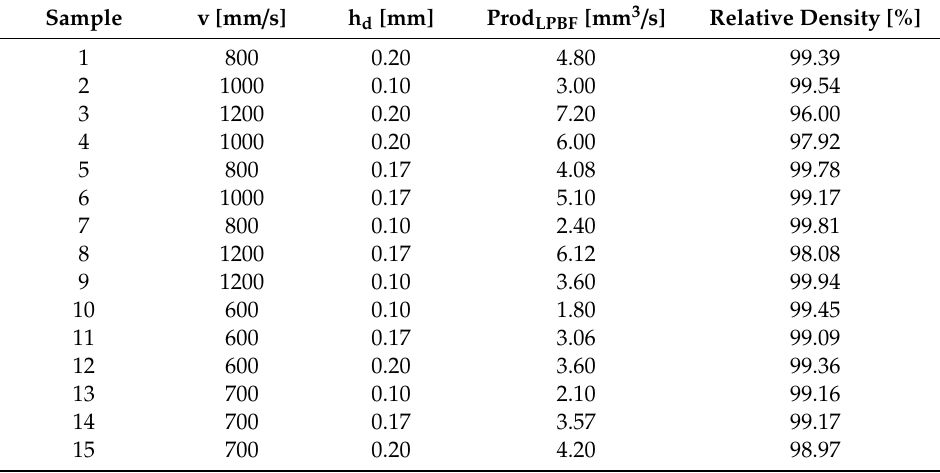
Table 2. Combination of process parameters, productivity, and relative density of A357 samples.